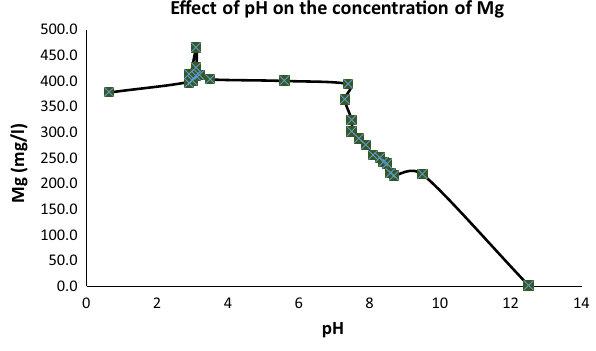
Fig. 3 Effect of pH on the concentration of